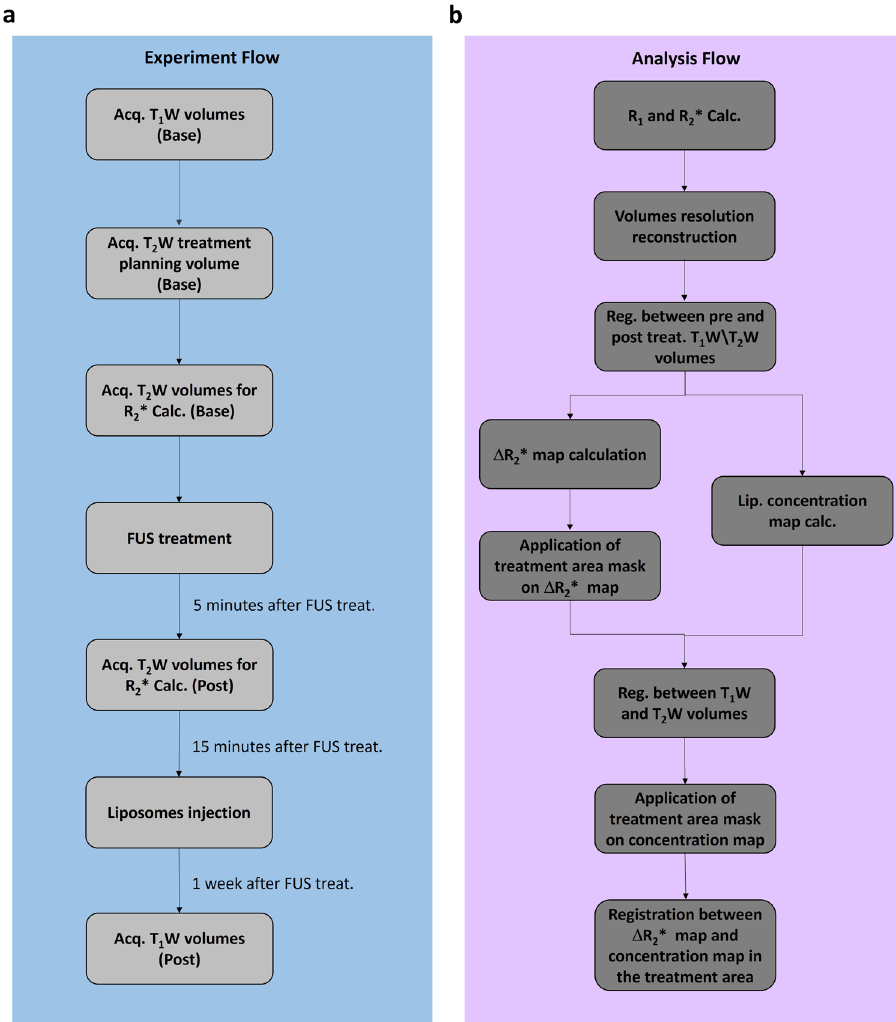
Fig. 2 Experiment and MRI analysis fl ow. a Experiment description: the experiments started with baseline T 1 -weighted volume acquisition, followed by T T R 2 -weighted images to place the treatment targets. Before FUS treatment, 2 -weighted GRE volumes were acquired to calculate baseline 2 * values. After the FUS treatment, GRE volumes were acquired again to calculate the post-treatment R 2 * and, consequently, treatment-related Δ R 2 *. The liposomes were injected ~15 min after the treatment, followed by T 1 -weighted volume acquisition 1 week after the treatment. b MR images analysis fl ow: analysis started with pre- and post-treatment R 2 * and R 1 volume calculations, followed by volume reconstruction to symmetric voxel 0.5 3 mm 3 . Then registration between pre- and post-treatment T 2 -weighted volumes and pre- and post-treatment T 1 -weighted volumes led to the Δ R 2 * and Δ R 1 calculations. The Δ R 1 value was converted to the Gd-liposome concentration using the calibration curves shown in Supplementary Fig. 2. The treatment mask was extracted from the Δ R 2 * map using the sub-spot location. After registration between T 1 - and T 2 -weighted volumes, treatment masks were applied to the Gd-liposome concentration volume to isolate concentration changes related to the treated area. To mimic the liposome diffusion, registration between the Δ R 2 * and Gd-liposomal concentration maps in the treated area was performed to fi nd the geometric correlation between the two